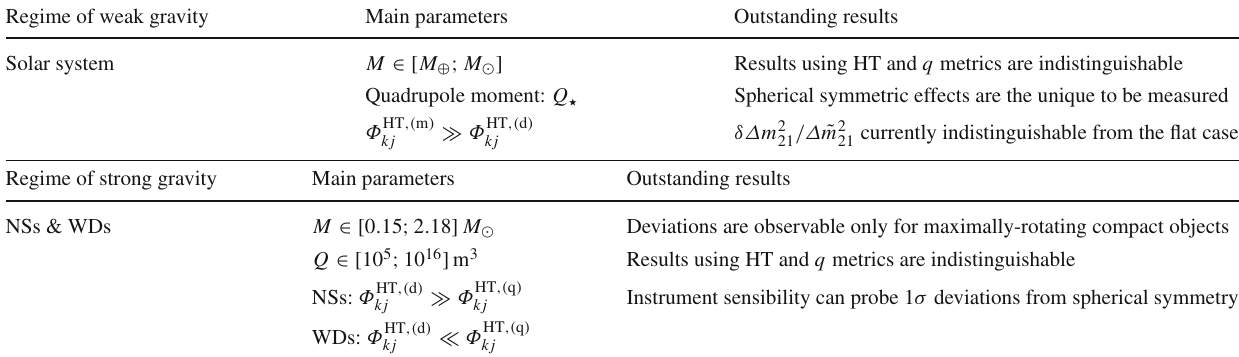
. The expected values are reported in view of possible future experiments 21